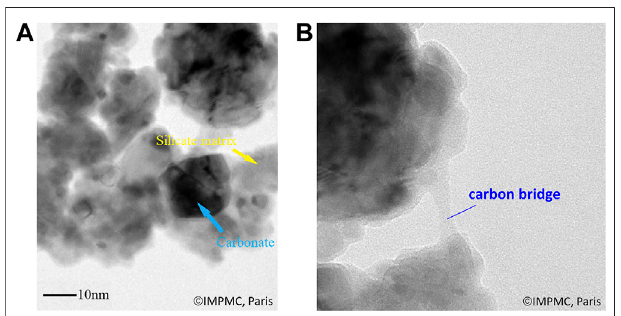
FIGURE9| Predictedeffectofthecorrosionofstainlesssteelgrindingbeadsoncarbonationproducts(T=175 ° C,P CO2 =20bar)forslagdescribedas (A) system1 (major metal oxides only) and (B) system 2 (major and minor metal oxides).